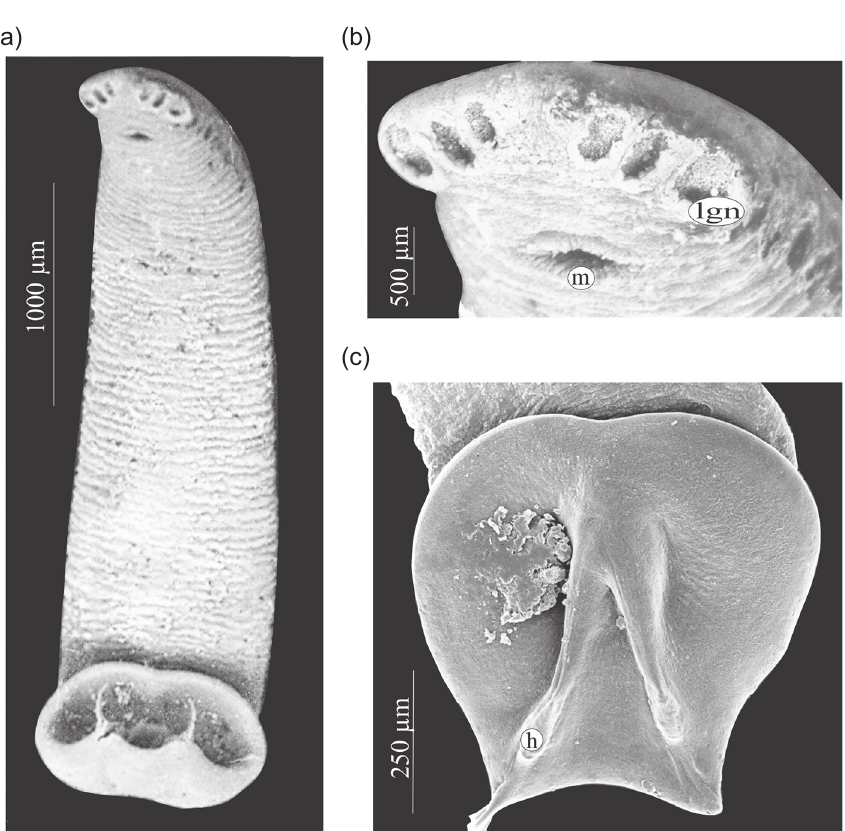
Figure 3. Triloculotrema euzeti n. sp., scanning electron micrographs. (A) Whole body (ventral view), (B) enlarged view of head region, (C) haptor. Abbreviations: h, hamulus; m, mouth; lgn, anterolateral glands containing needle-like secretion.